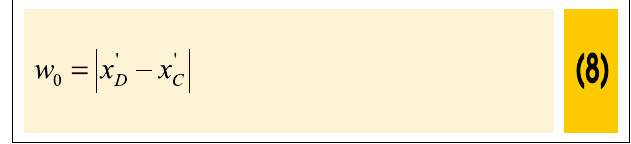
From Figure 7(a) it is